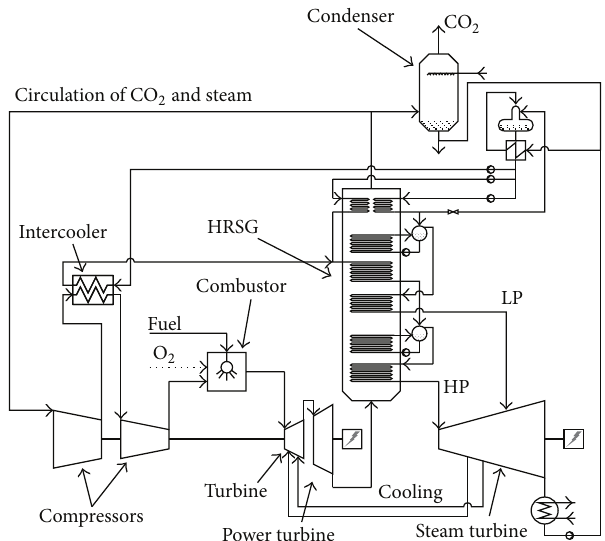
Figure 3: Schematic layout of the Graz cycle.